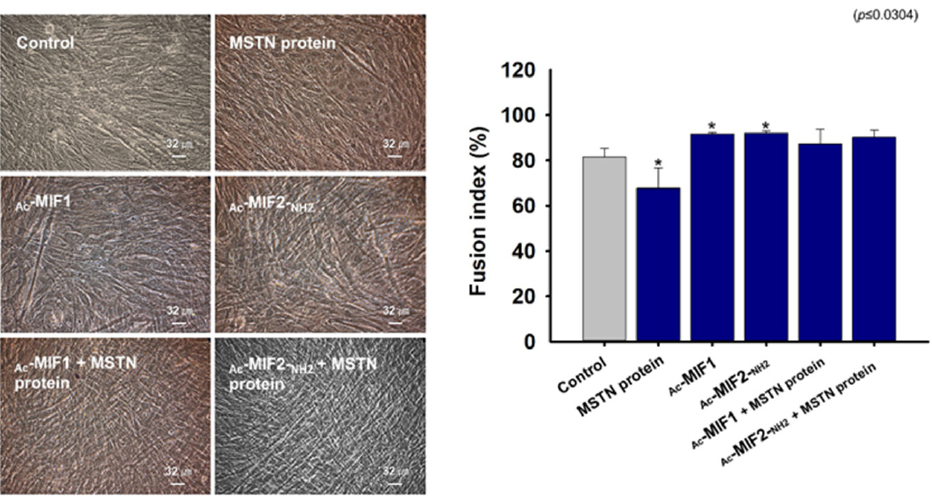
Figure 5. Effects of MSTN protein plus Ac -MIF 1 or Ac -MIF2- NH2 peptide treatments on myogenic differentiation. When C2C12 cells were 100% confluent, growth medium was switched to myogenic differentiation medium supplemented with MSTN protein or Ac -MIF1, Ac -MIF2- NH2 , MSTN protein + Ac -MIF1, or MSTN protein + Ac -MIF2- NH2 for 3 days. Myotube formation was observed and fusion indices determined by Giemsa staining. Non-treated cells were used as controls. Means ± SD ( n ≤ 3). * p ≤ 0.05, ** p ≤ 0.001, *** p ≤